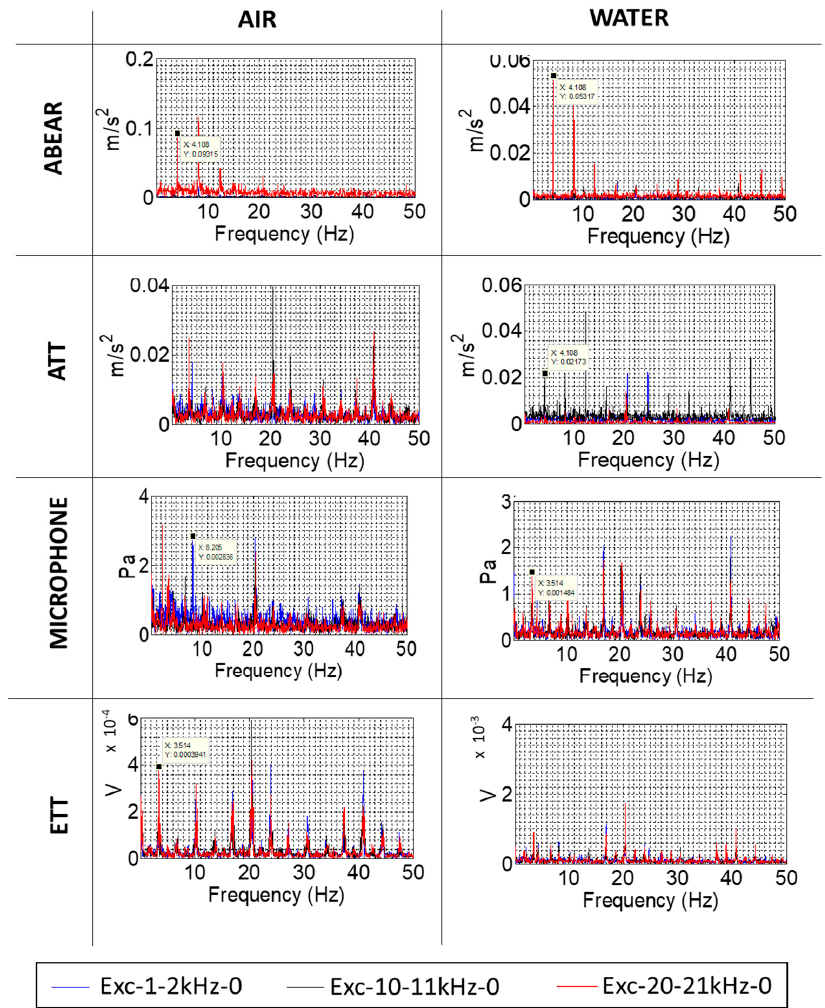
Figure 8. Amplitude demodulation for the sensors on the stationary frame and the excitation without any modulating frequencies. Rotating case ( f f = 4.1